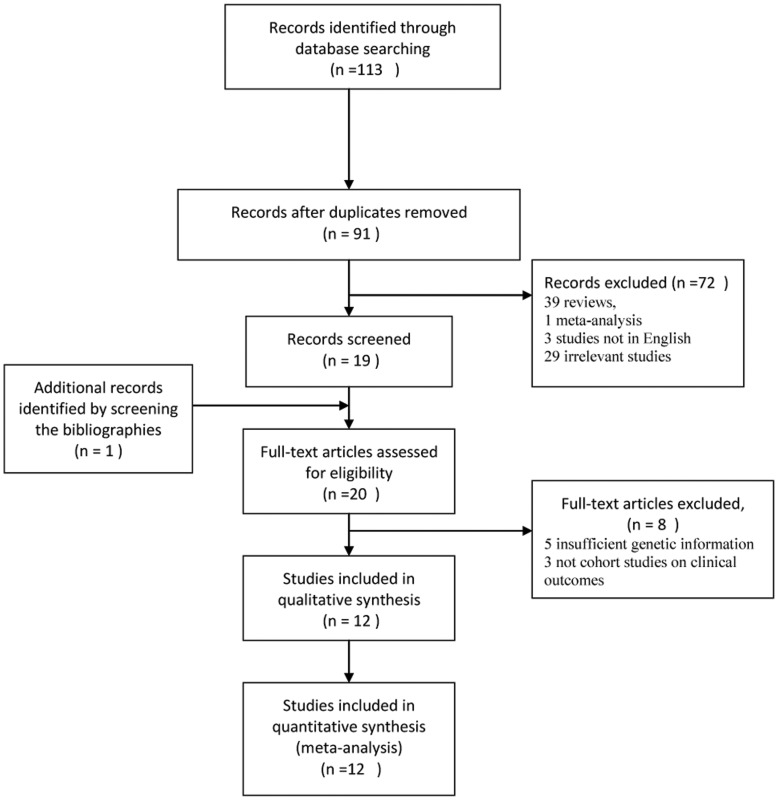
Flow diagram of the trial selection process.